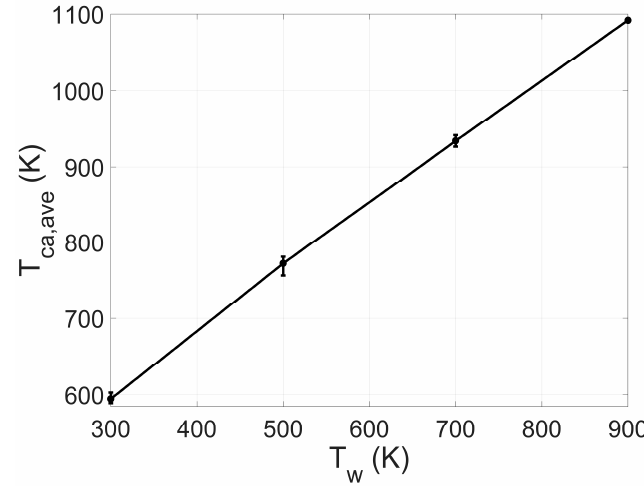
Figure 7. Average temperature at the cutting area ( T ca,ave ) vs. workpiece temperature ( T w ).